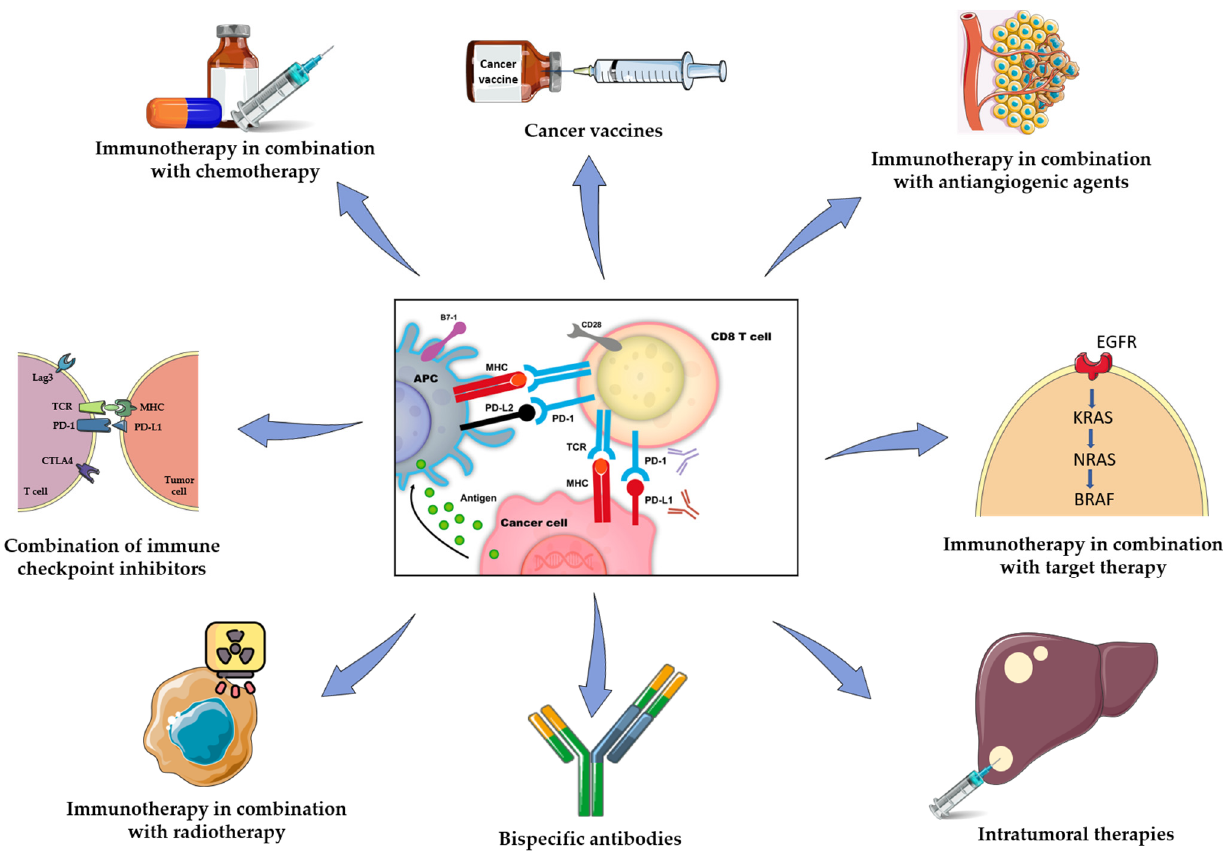
Figure 1. Approaches investigated so far to overcome immune resistance and develop an effective immune response against tumor cells for MSS mCRC. Created with smart.servier.com, accessed on 8 December 2021.